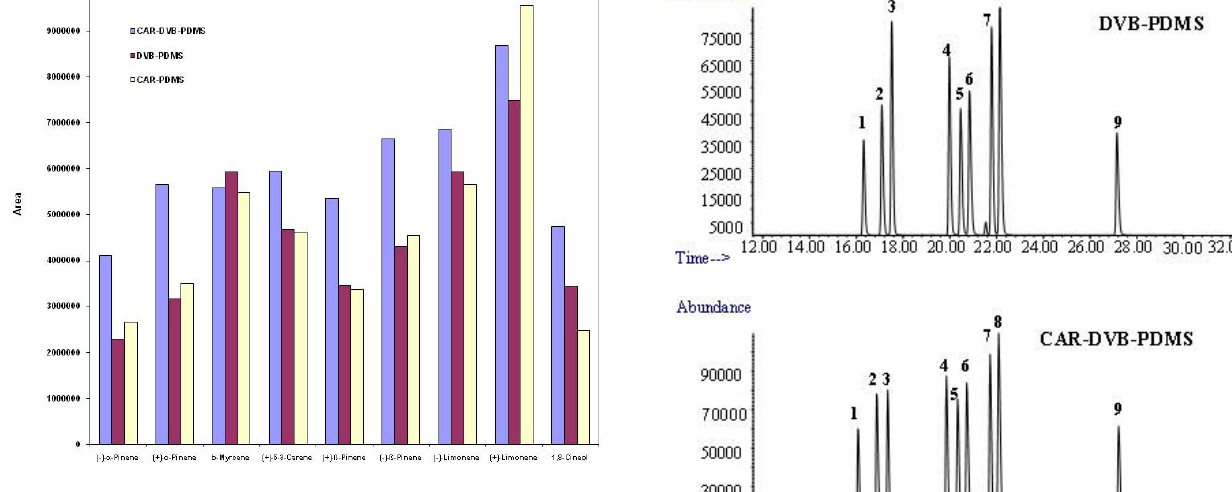
Fig. 3. A comparison of the extraction efficiencies of DVB-PDMS, CAR-PDMS and CAR-DVB-PDMS for monoterpenes.